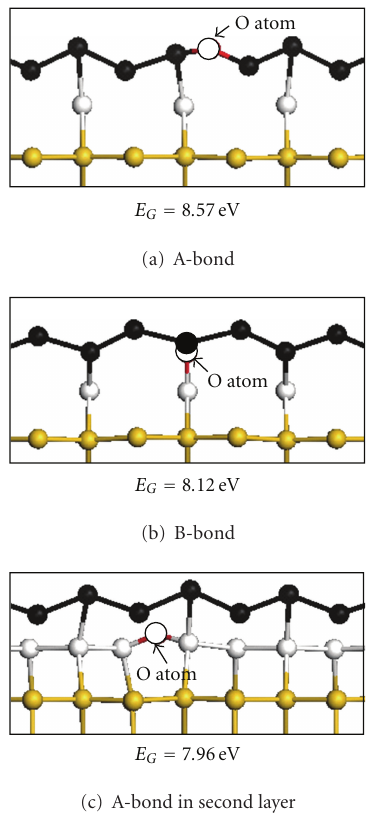
Figure 3: Cross sections of stable structures and energy gains E G with O absorption at (a) A-bond, (b) B-bond, and (c) A-bond in second layer. Black (white) balls indicate the Si atoms in the first (second) layer. O atoms are indicated in each figure. The coverage ratio R ox = 0 . 03.